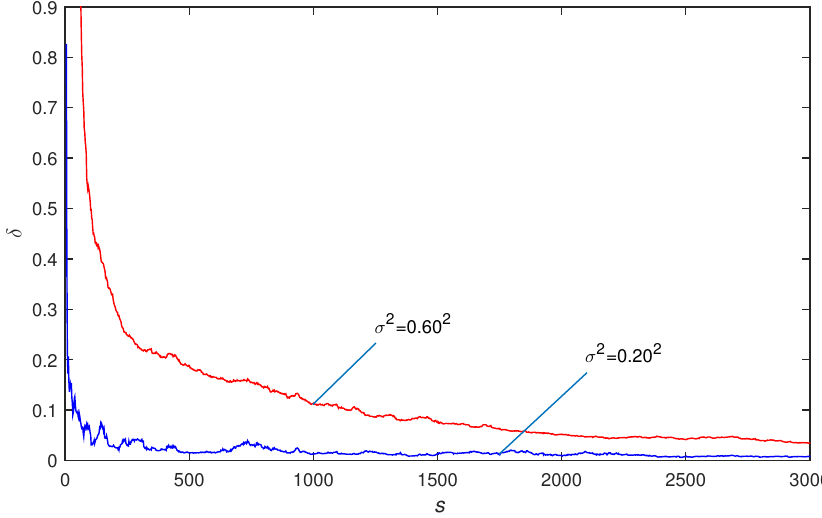
Figure 3. The RGELS, PC-S-RGELS and PC-RGELS estimation errors δ versus s .